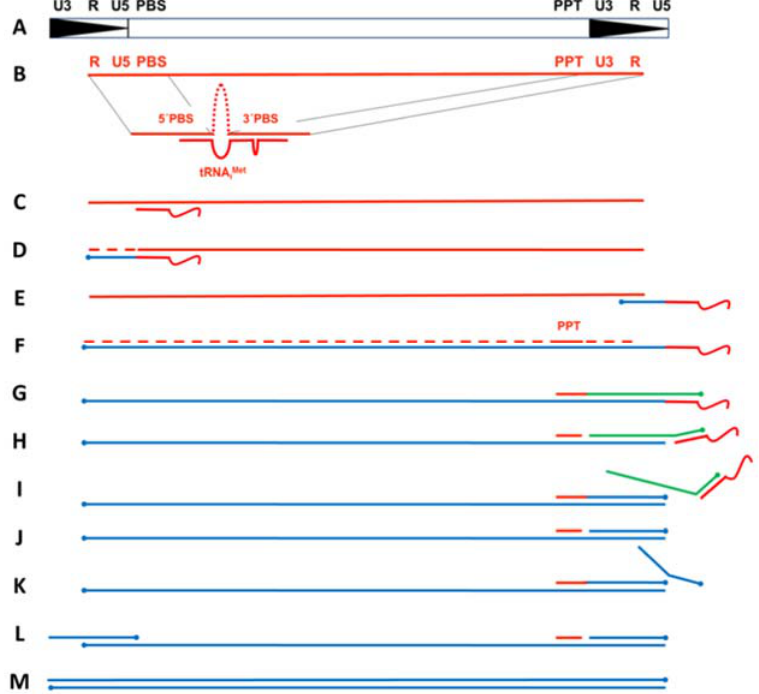
Figure 1. Ty3 Reverse Transcription Cycle. ( A ) Structure of the double stranded preintegrative Ty3 DNA (black). U3, unique 3 ′ sequence; R, repeat sequence; U5, unique 5 ′ sequence; PBS, primer binding site; PPT, polypurine tract; ( B ) Genomic RNA is depicted in red. The bipartite nature of the PBS comprises sequences from both the 5 ′ PBS and the 3 ′ U3 regions; ( C ) Simplified initiation complex